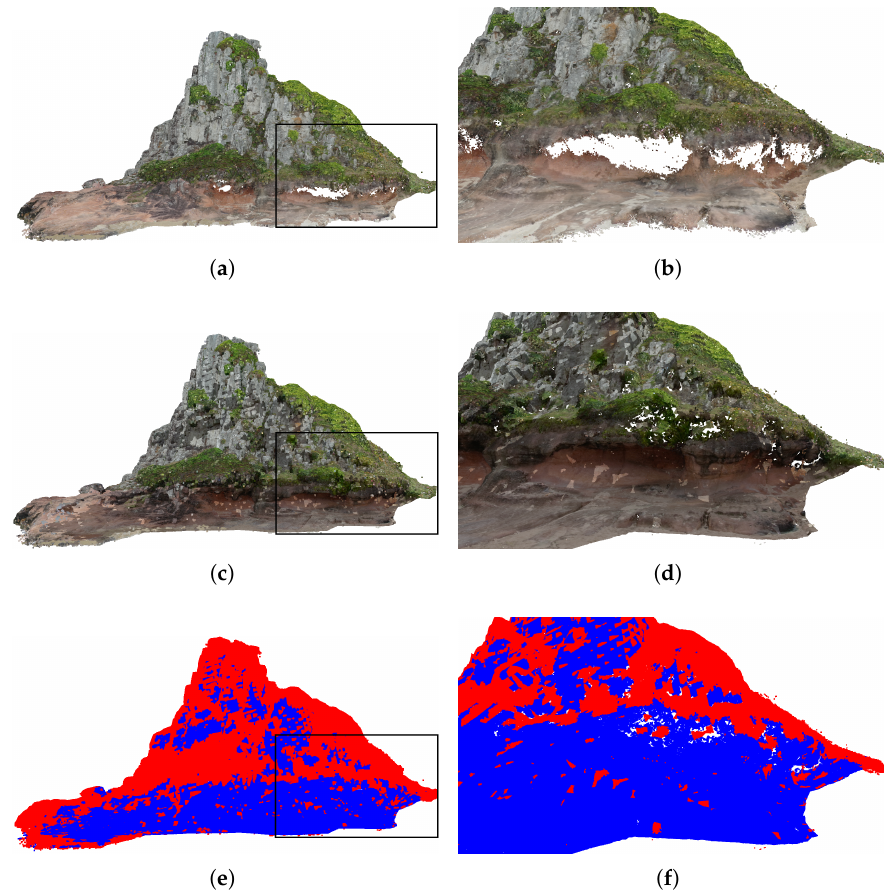
Figure 10. Result of the optimized integration between UAV and SPI point clouds. ( a , b ) Bottom part of the UAV point cloud with several gaps caused by occlusion of subvertical features. ( c , d ) Same region after integration of sensors. ( e , f ) Resulting octree analysis showing blue voxels filled with SPI points and red voxels filled with UAV